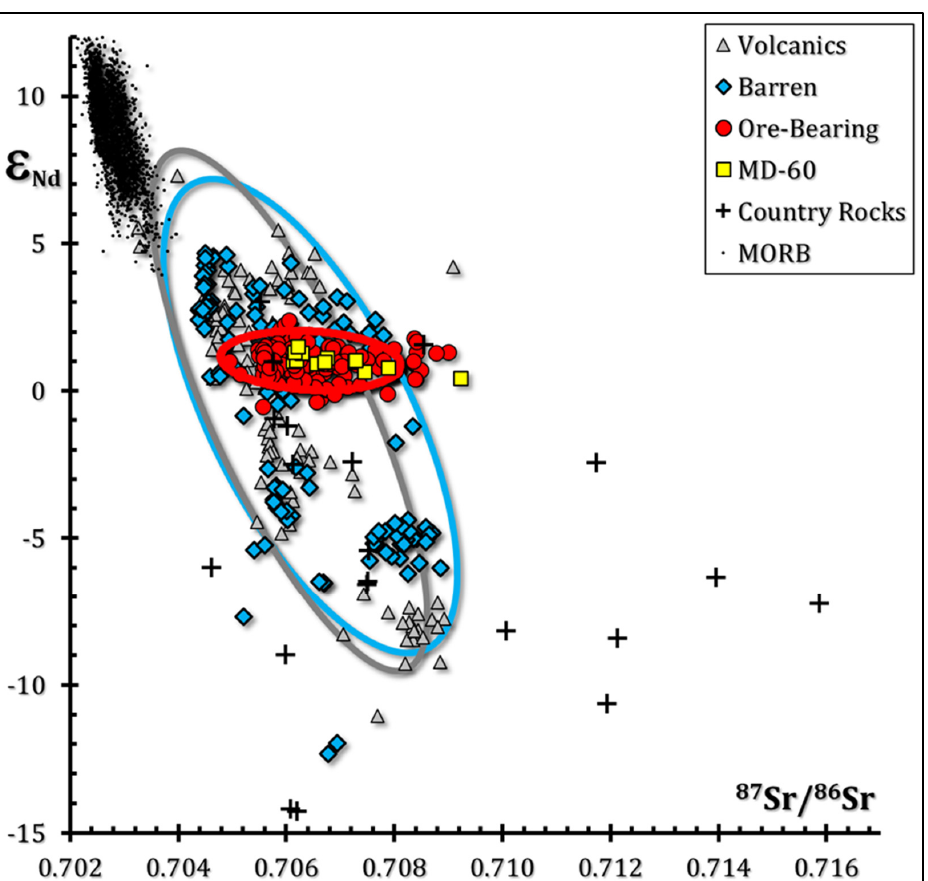
Figure 14. Initial Sr isotopic ratio and Ԑ Nd (T) variations in the magmatic rocks of the Norilsk region in comparison with MORB data [47,48] and the Norilsk area deep-seated basement country (sedimentary, granitic and metamorphic) rocks [28,30] . Two-sigma ellipses are shown for volcanic rocks (grey line), barren intrusive rocks (blue line), and ore-bearing intrusive rocks (red line) to present scatters of every type of data. Note the position of most of the Mikchangda rocks’ data (MD-60) inside the ore-bearing rocks ellipse.